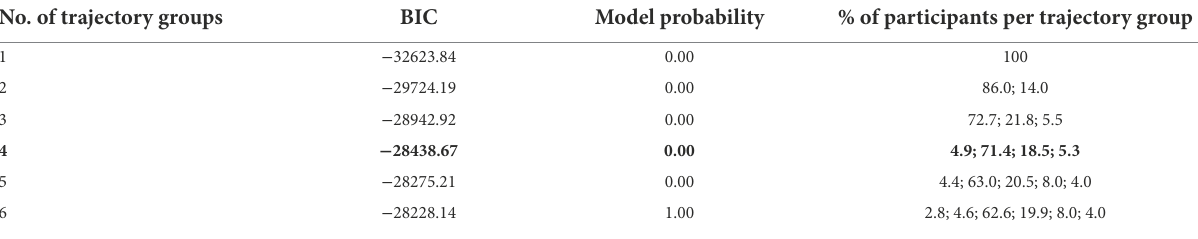
BIC = Bayesian information criterion. All trajectories were coded in cubic order. The bold values correspond to the selected model.